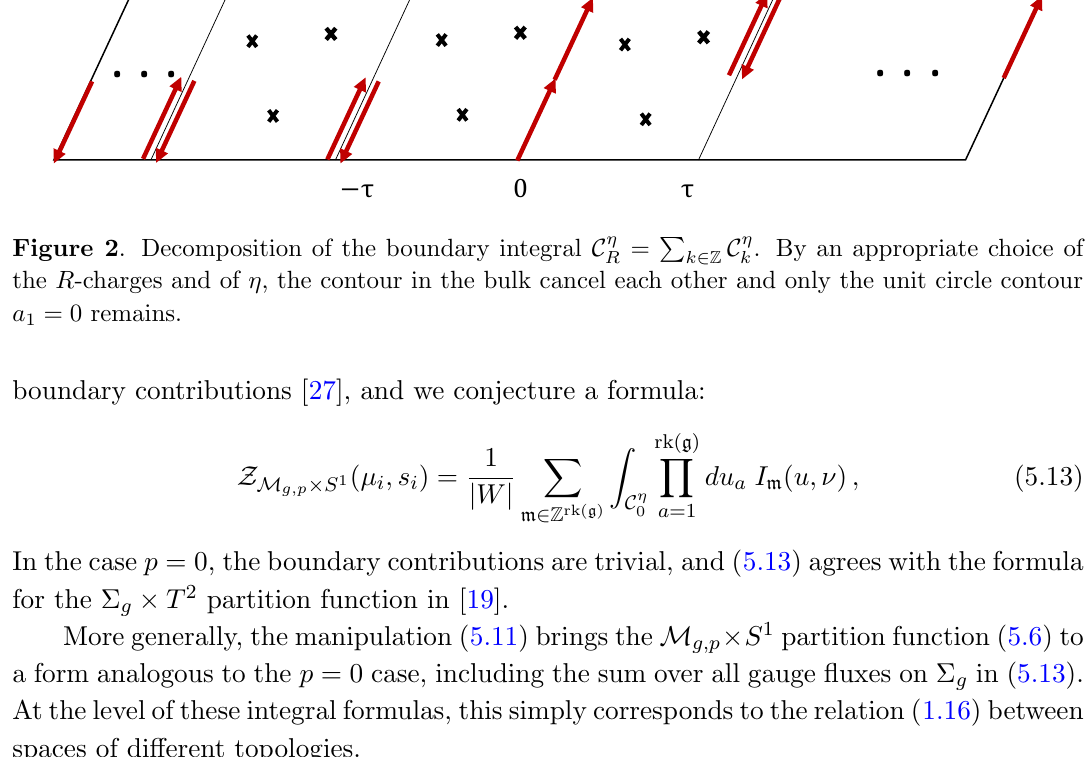
= P C (cid:17) . By an appropriate choice of R k 2 Z k